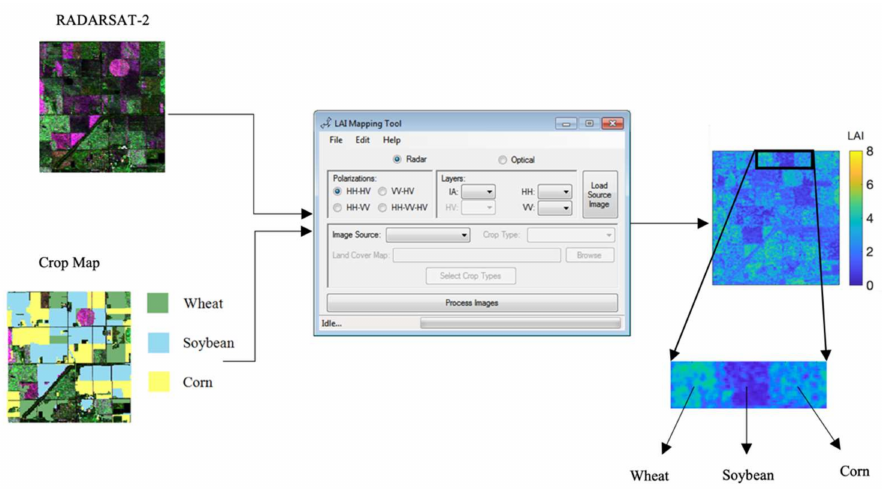
Figure 7. The LAI mapping tool and the LAI map generated from the WCM model using a RADARSAT-2 image of 12 June 2012, over the Canada JECAM site in Carman,